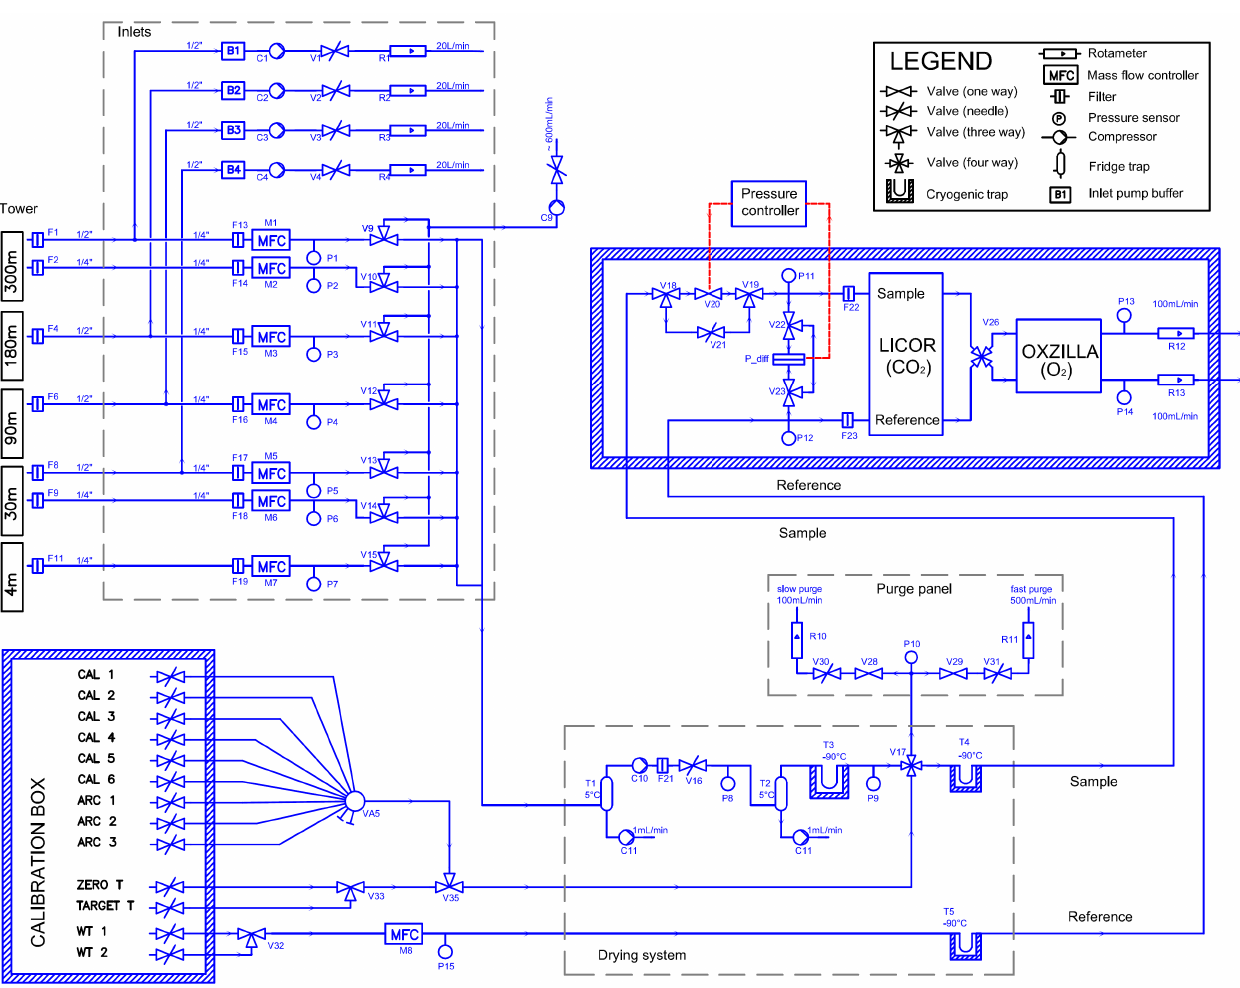
Fig. 2. Flow diagram of the CO 2 and O 2 /N 2 measurement